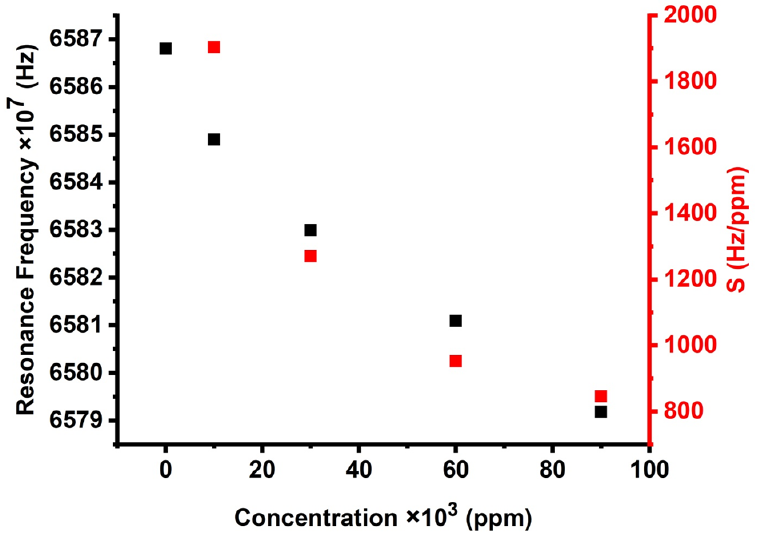
Figure 10. The effect of different concentrations on the resonance peaks and sensitivity of cadmium bromide liquid sensor.